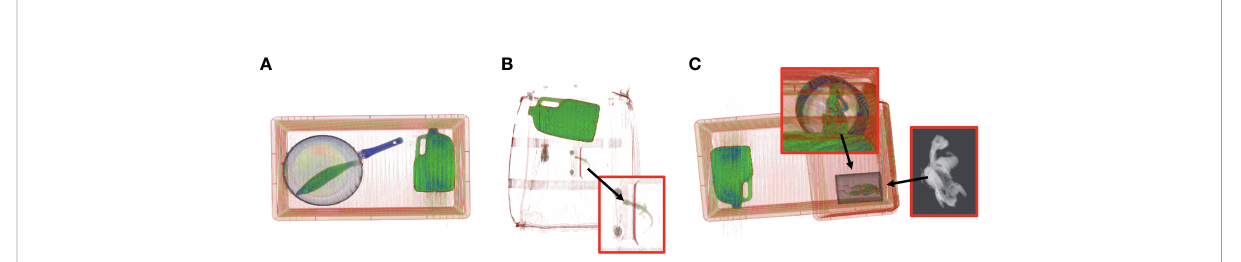
FIGURE 2 Scanned wildlife examples using Real Time Tomography 3D X-ray imaging (Rapiscan Systems RTT110). All wildlife in the study were initially scanned alone to train computer-based algorithms to learn the shapes of various species. Individual animals were later scanned in more complicated scenarios with other items varying in shape and density to train algorithms for wildlife detection. Examples of wildlife scans with varying degrees of complexity include; (A) Eastern school whiting fi sh ( Sillago fl indersi ) under fry pan and next to three litre water bottle (B) Australian water dragon ( Intellagama lesueurii ) in complicated luggage type scenario with metal toy car, sock and water bottle and (C) Rainbow lorikeet parrot ( Trichoglossus moluccanus ) placed in chocolate milk tin. This is a replication of previously seized traf fi cking example in